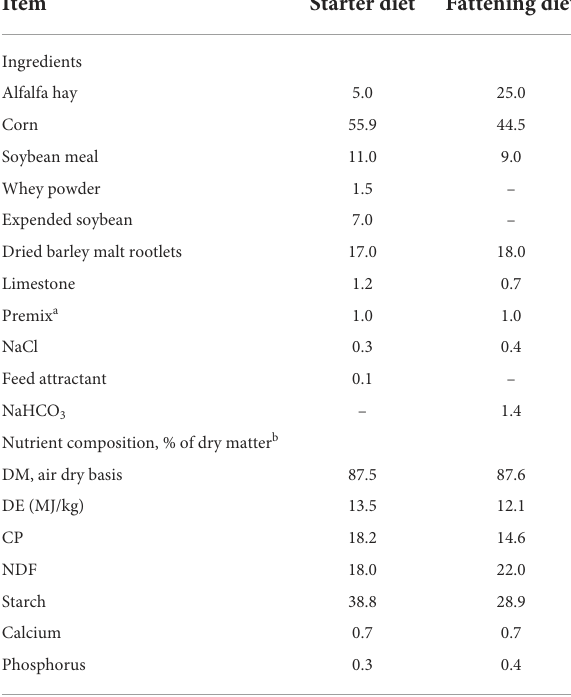
TABLE 1 Ingredients and chemical composition of experimental diet (%, DM